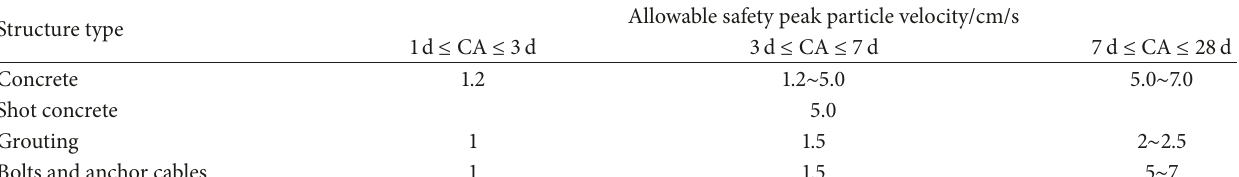
Table 3: Relevant safety criteria for tunnel lining structures [32].